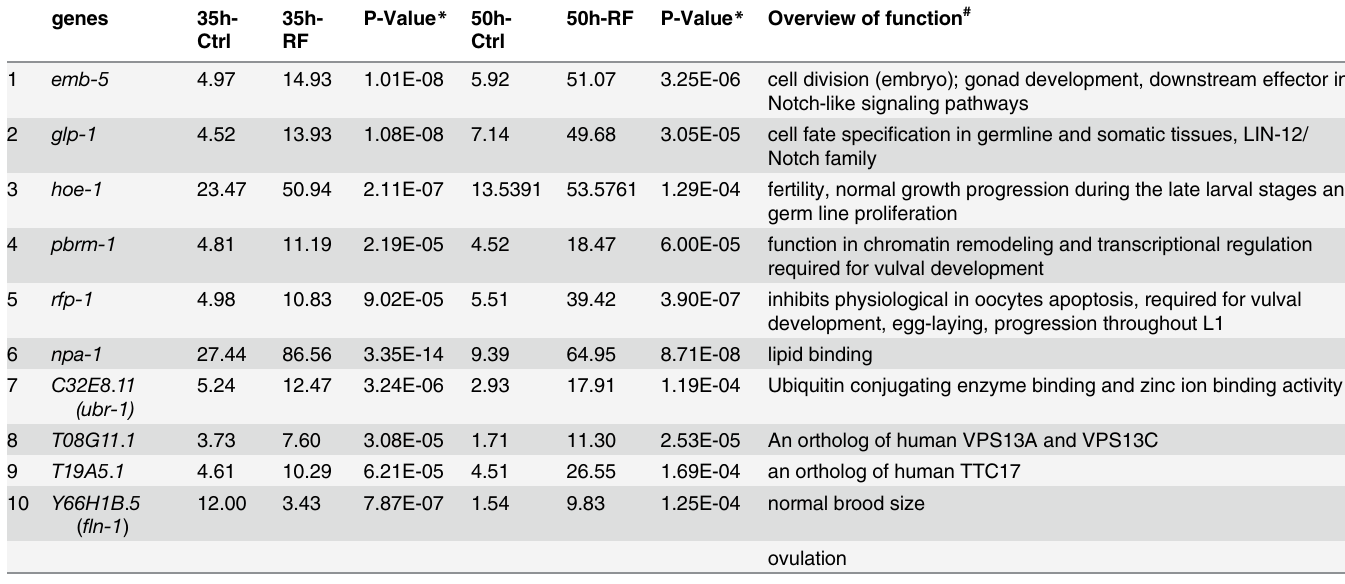
Table 1. Genes Showing Significant Expression Changes in RF-Exposed Compared to Sham Controls at both L4 and adult gravid stages.